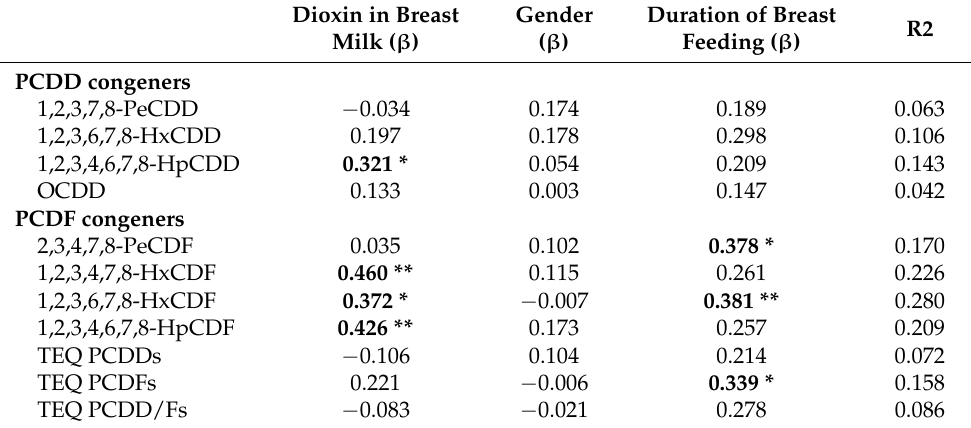
Table 4. Relationship of dioxin level in children’s serum and their gender, duration of full breast feeding, and dioxin level in breast milk in the hotspot assessed by using linear multiple regression. Dioxin in